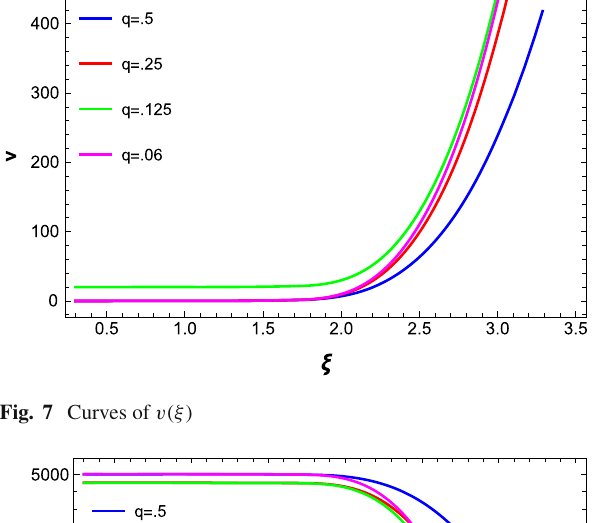
Fig. 7 Curves of v(ξ)